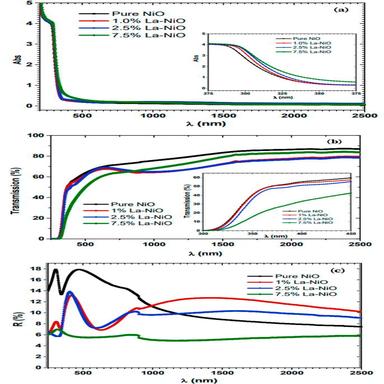
Absorption (a), Transmittance (b) and Reflectance (c) versus wavelength of pure and La doped thin films.